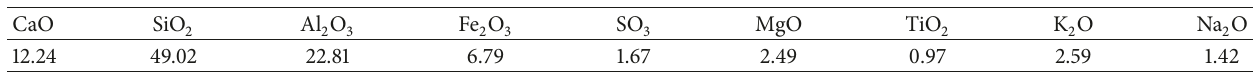
Table 5: Chemical composition of fly ash (%).